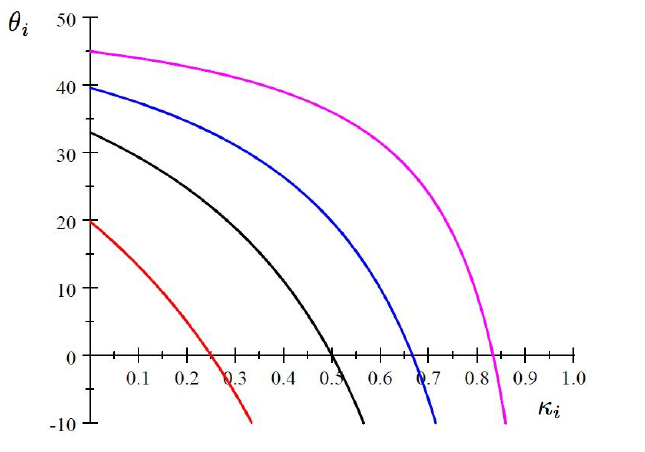
Figure 7. Thresholds for switching to A, as a function of the degree of morality, in a population of size n = 100. Starting from the bottom, the curves correspond to v = 4, v = 2, v = 1.5, and v =